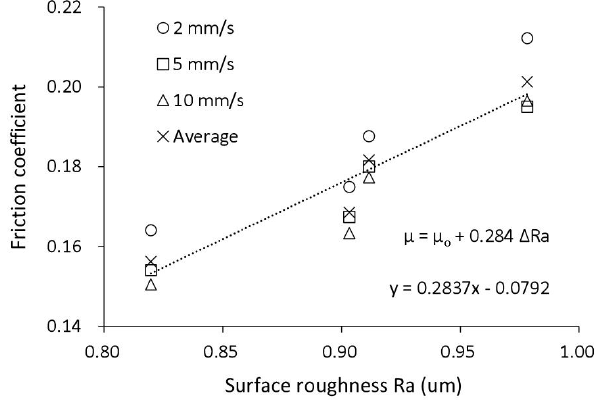
Figure 21. Relationship between surface roughness and friction co-